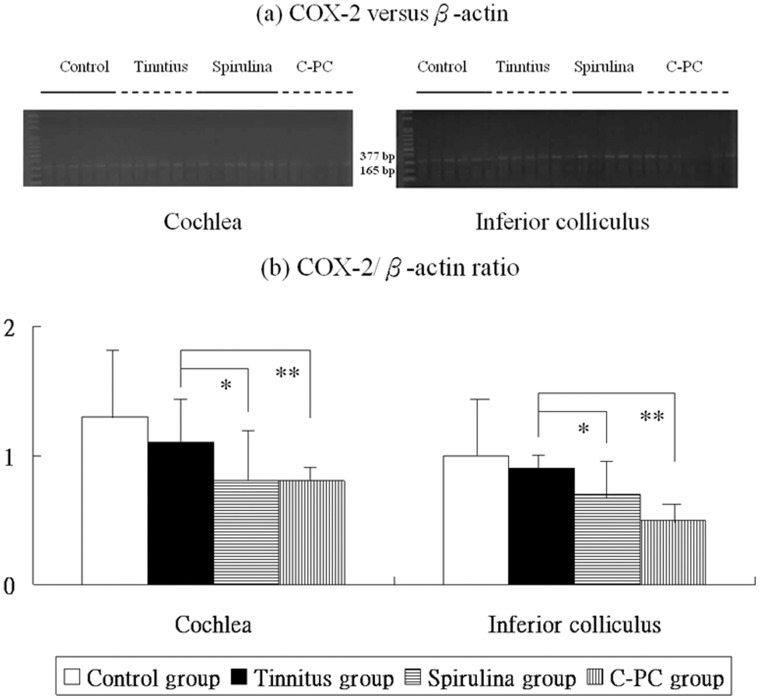
The levels of COX-2 mRNA expression in the four groups (a,b).There are significant differences in these levels among the four groups. The COX-2 mRNA expression were significantly higher in the salicylate group than the control group. Compared to the tinnitus group, the Spirulina group (*) or C-PC group (**) exhibits significantly reduced COX-2 mRNA levels in the cochlea and IC.